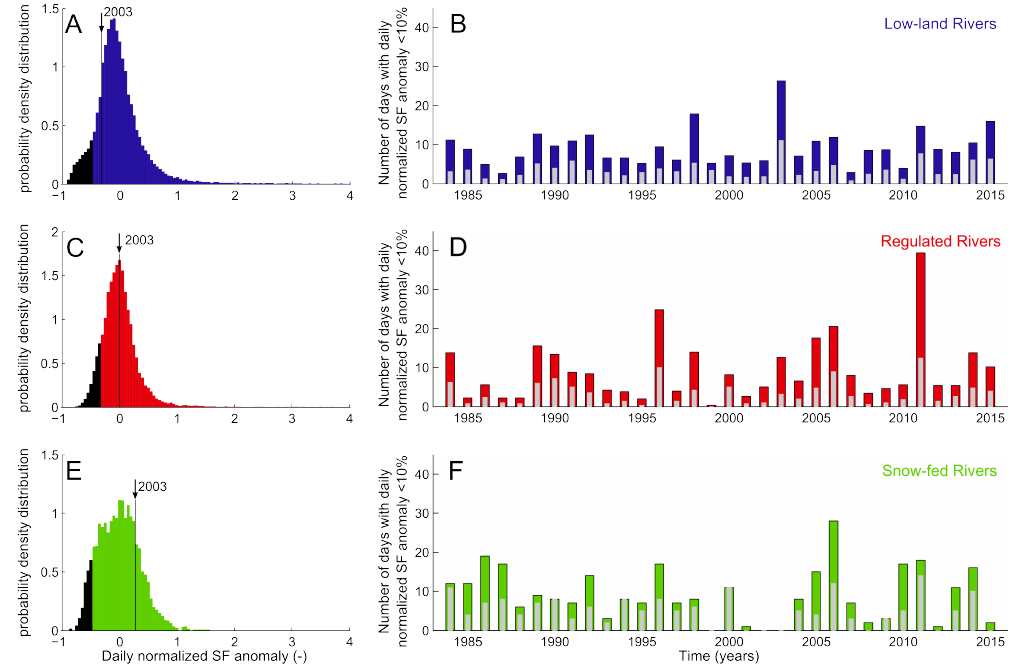
Figure 3. Distributions of daily anomalies in normalized streamflow for low-land ( A ), regulated ( C ) and snow-fed ( E ) rivers during JJA. Shaded areas show the bottom 10th percentile in the distribution and arrows indicate the averaged anomalies for the heatwave in 2003. The number of days below 10% is shown in the right column ( B , D , F ) for the period 1984–2015, with inset bars indicating the number of consecutive